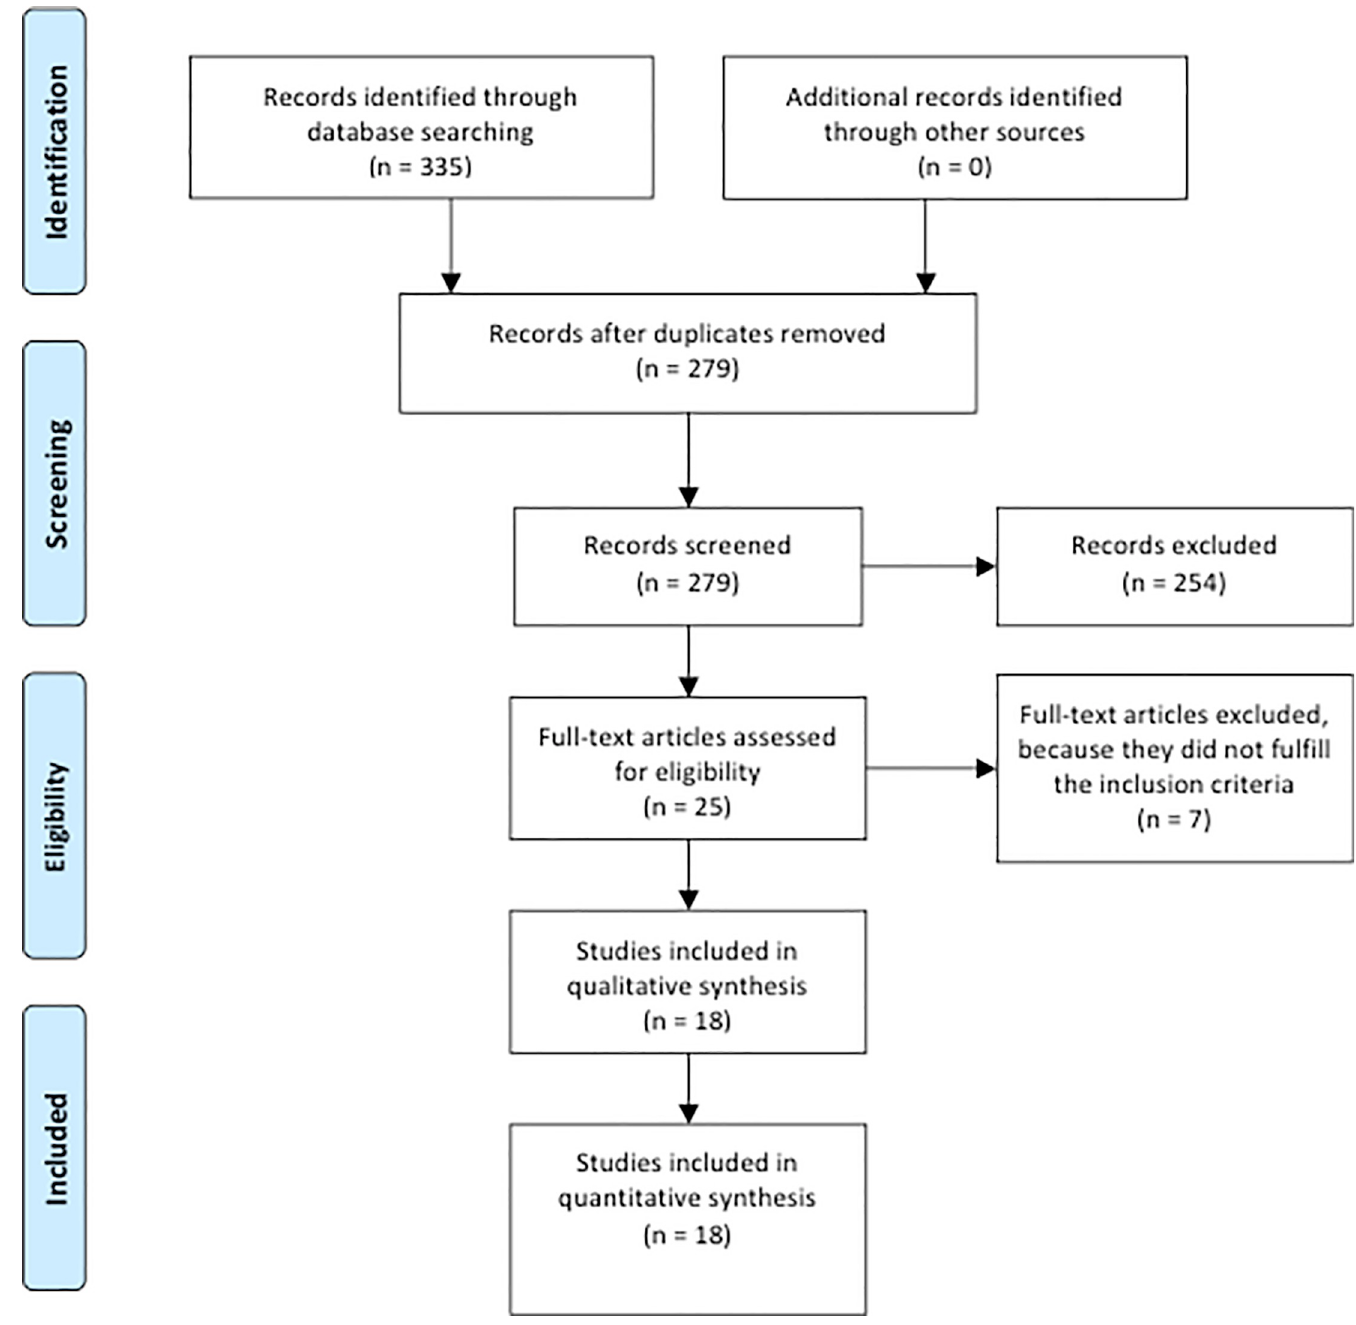
Fig 1. PRISMA 2009 flow